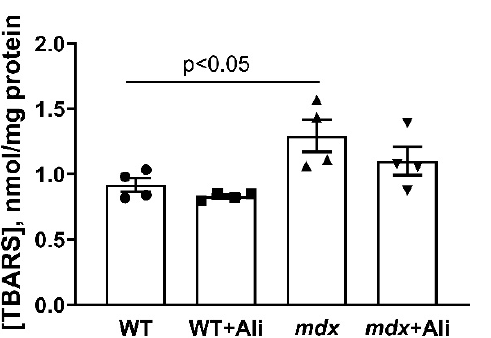
Figure 4. Effect of alisporivir on lipid peroxidation in mouse heart mitochondria. Lipid peroxida- tion was assessed by the level of TBARS in the heart mitochondria of experimental groups of ani- mals. The data are presented as means ± SEM ( n = 4).